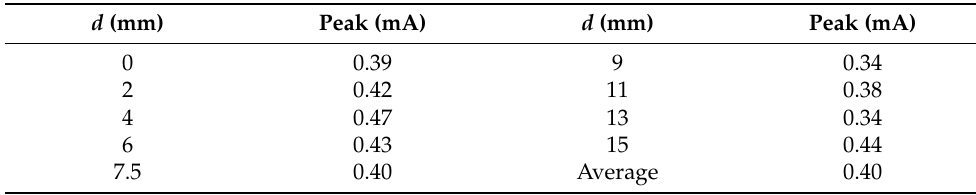
Table 2. The Peak Value of Corona Current for Particle Size = 5 mm.